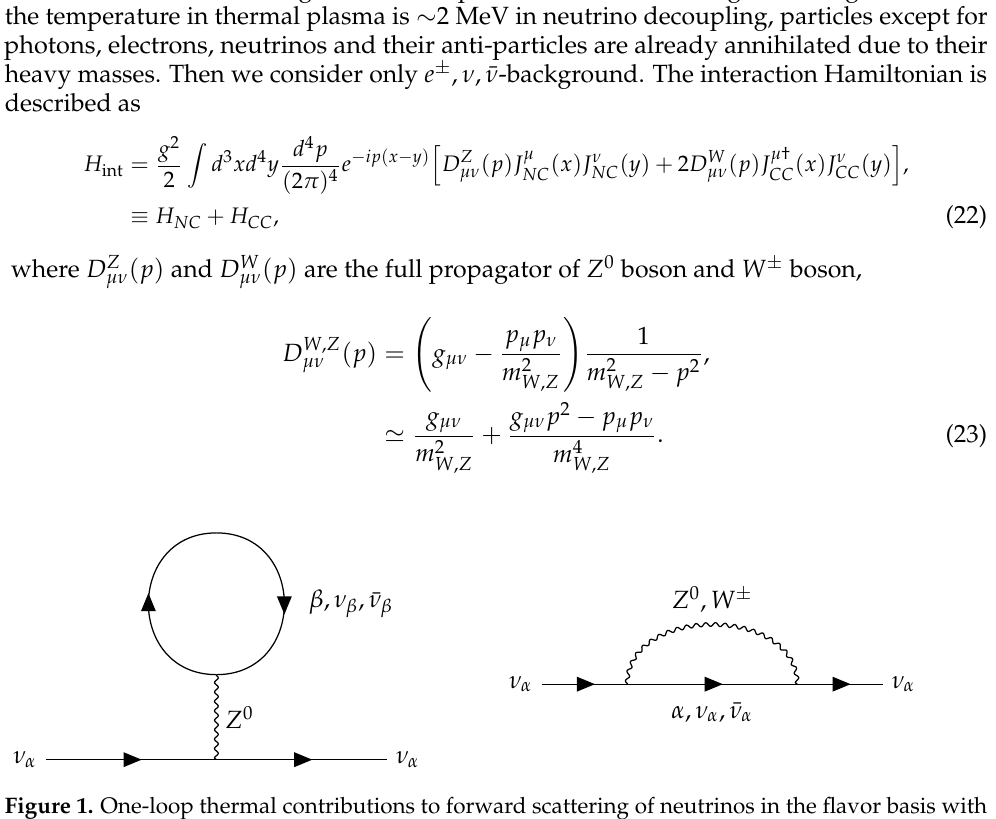
Figure 1. One-loop thermal contributions to forward scattering of neutrinos in the flavor basis with α , β = e ± , µ ± and τ ± . ( Left ) Tadpole diagram with all flavors in the one-loop. ( Right ) Babble diagram with the same flavor in the